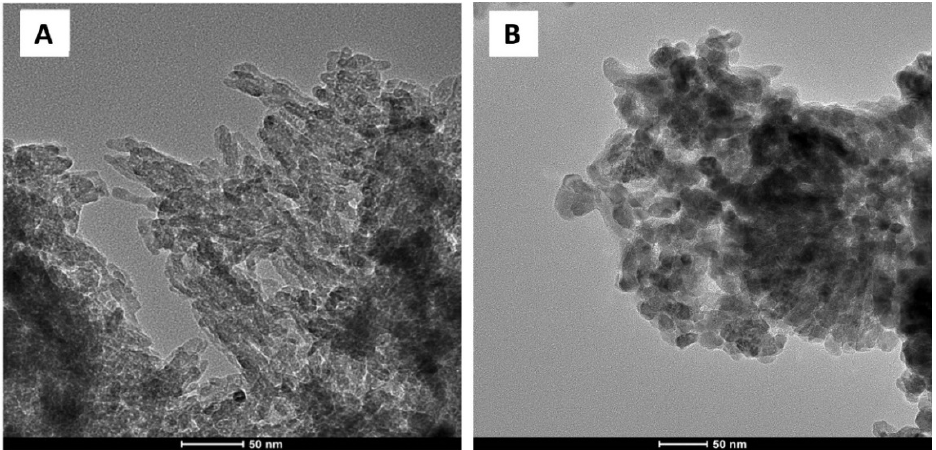
Figure 2. HRTEM images of nHA ( A ) and nZnO:Ag ( B ).